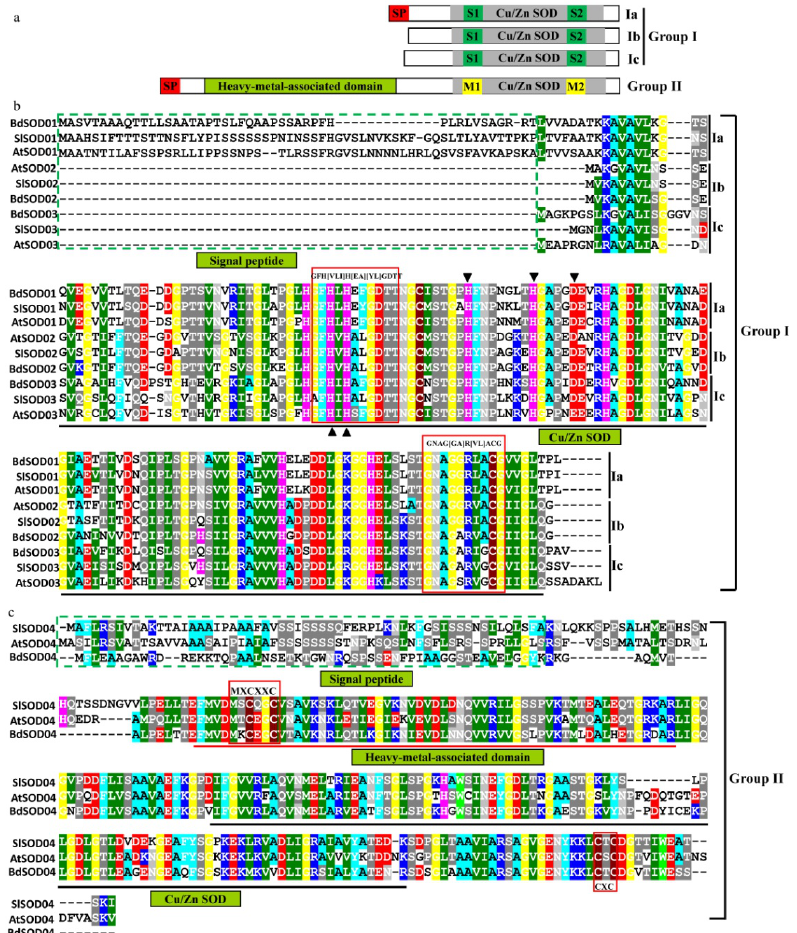
Figure 2. The domain architecture and sequence conservation of plant Cu/Zn SOD proteins. ( a ) Schematic representation of domain architecture of each type of Cu/Zn SOD protein. ( b ) Multiple sequence alignment of the deduced amino acid sequences of Cu/Zn SOD proteins. The conservation domain of Cu/Zn SOD without a heavy metal-associated domain is underlined. Two conserved Cu/Zn SOD signatures (GFH[VLI]H[EA][YL]GDTT and GNAG[GA]R[VL]ACG) are indicated by red boxes. The metal-binding sites for Cu 2+ and Zn 2+ are marked with regular and inverted triangles, respectively. The signal peptide is marked by a green box. ( c ) Multiple sequence alignment of the deduced amino acid sequences of Cu/Zn SOD with the heavy metal-associated domain. The conserved domains (“heavy metal-associated domain” and “Cu/Zn SOD”) were underlined (red and black, respectively). The conserved metal-binding motifs (MXCXXC and CXC) are marked by red boxes. The signal peptide is marked by a green